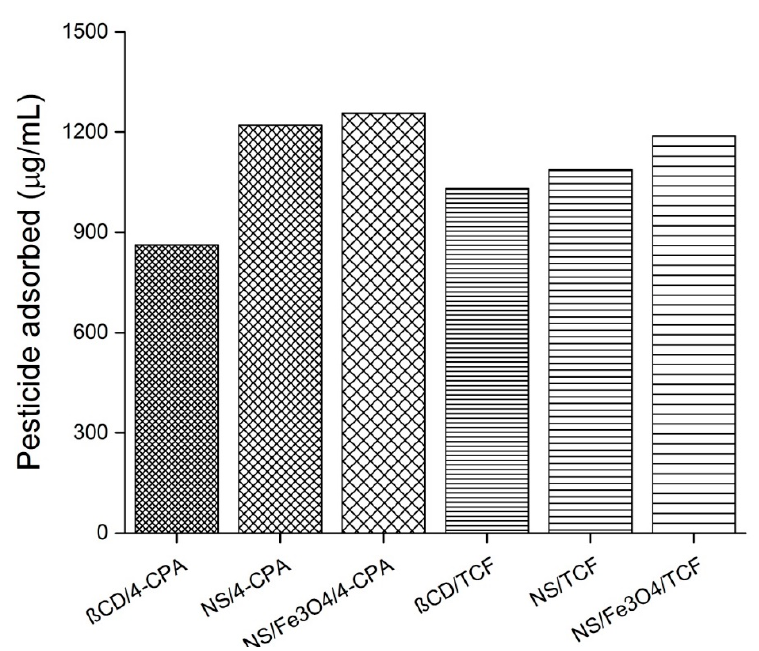
Figure 13. Amount of pesticide adsorbed with β -Cyclodextrin ( β -CD), nanosponges (NS), and Fe 3 O 4 /NS. Other abbreviations: 4-chlorophenoxyacetic acid (4-CPA), and 2,3,4,6-tetrachlorophenol (TCF).